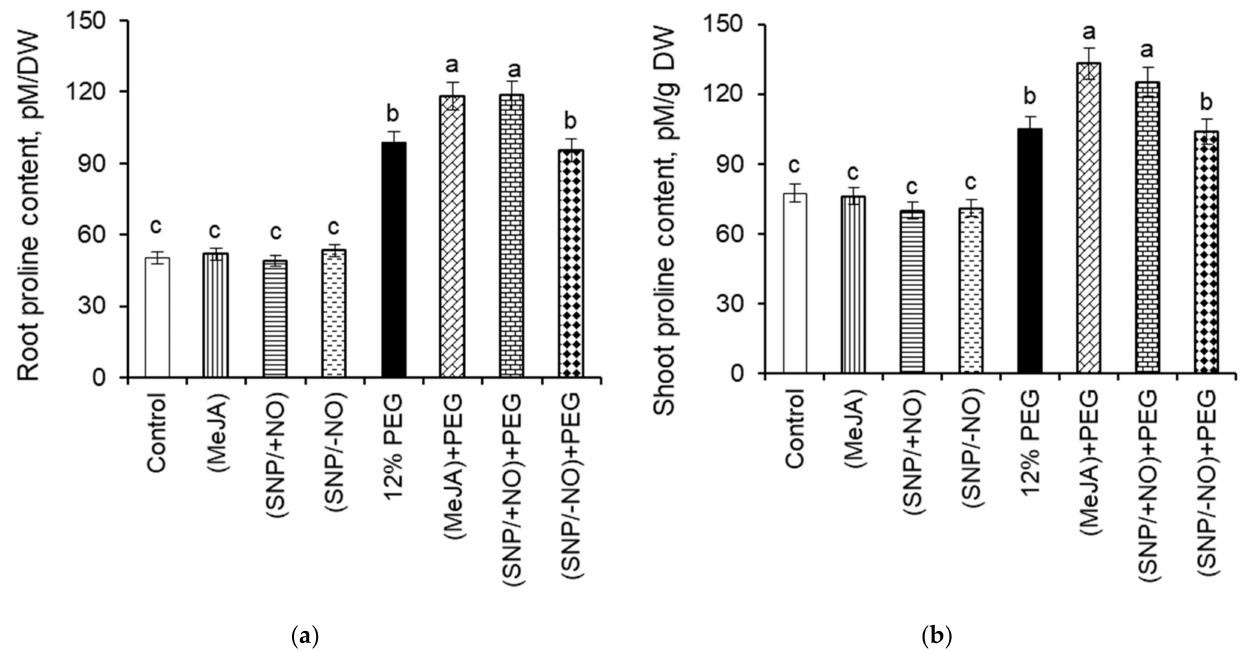
Figure 7. Proline content of roots ( a ) and shoots ( b ) of wheat plants pretreated by 10 − 7 M MeJA or 2 × 10 − 4 M SNP under 12% PEG treatment for 24 h, calculated to DW—dry weight, g. Data are the mean of three replicates; different letters show significant difference at p ≤ 0.05 and bars indicate ± SE (n =